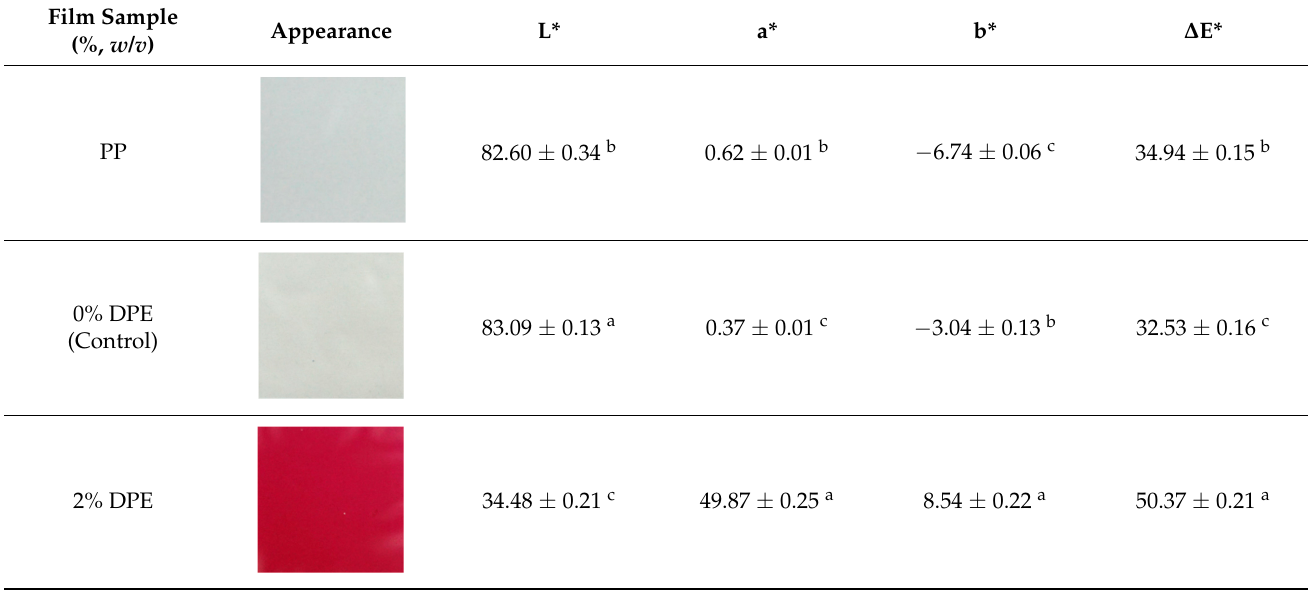
Table 2. Appearance and color values of polypropylene and DPE-enriched biocomposite films.